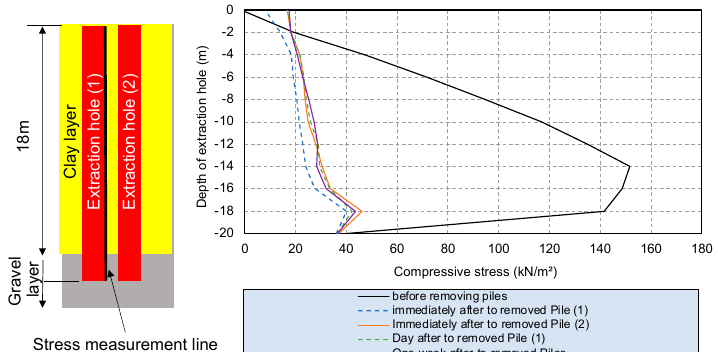
Figure 10. Compressive stress concentrated on two extraction holes of removed piles.